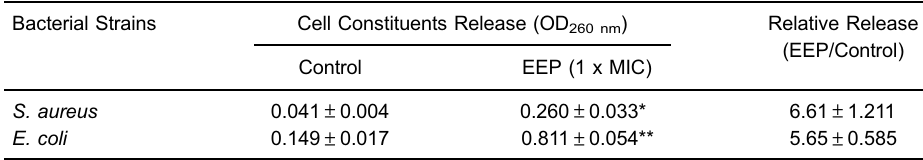
Data are reported as means ± SE of three independent experiments performed in triplicate. *P=0.0004 and **P=0.0001 compared to respective control ( t